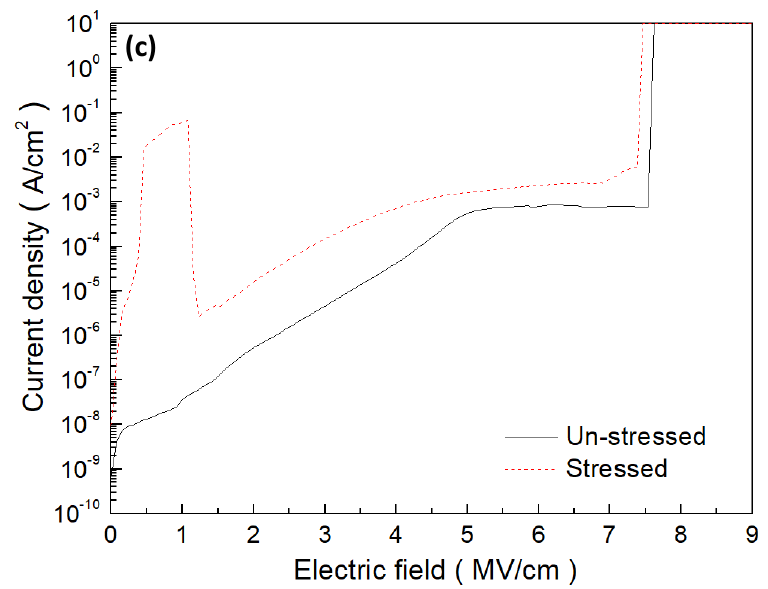
Figure 8. Comparison of I-E curves after being subjected to electric stress at 5 MV/cm: ( a ) pristine; ( b ) APTMS-SAMs; ( c ) DTMOS-SAMs p-SiOCH